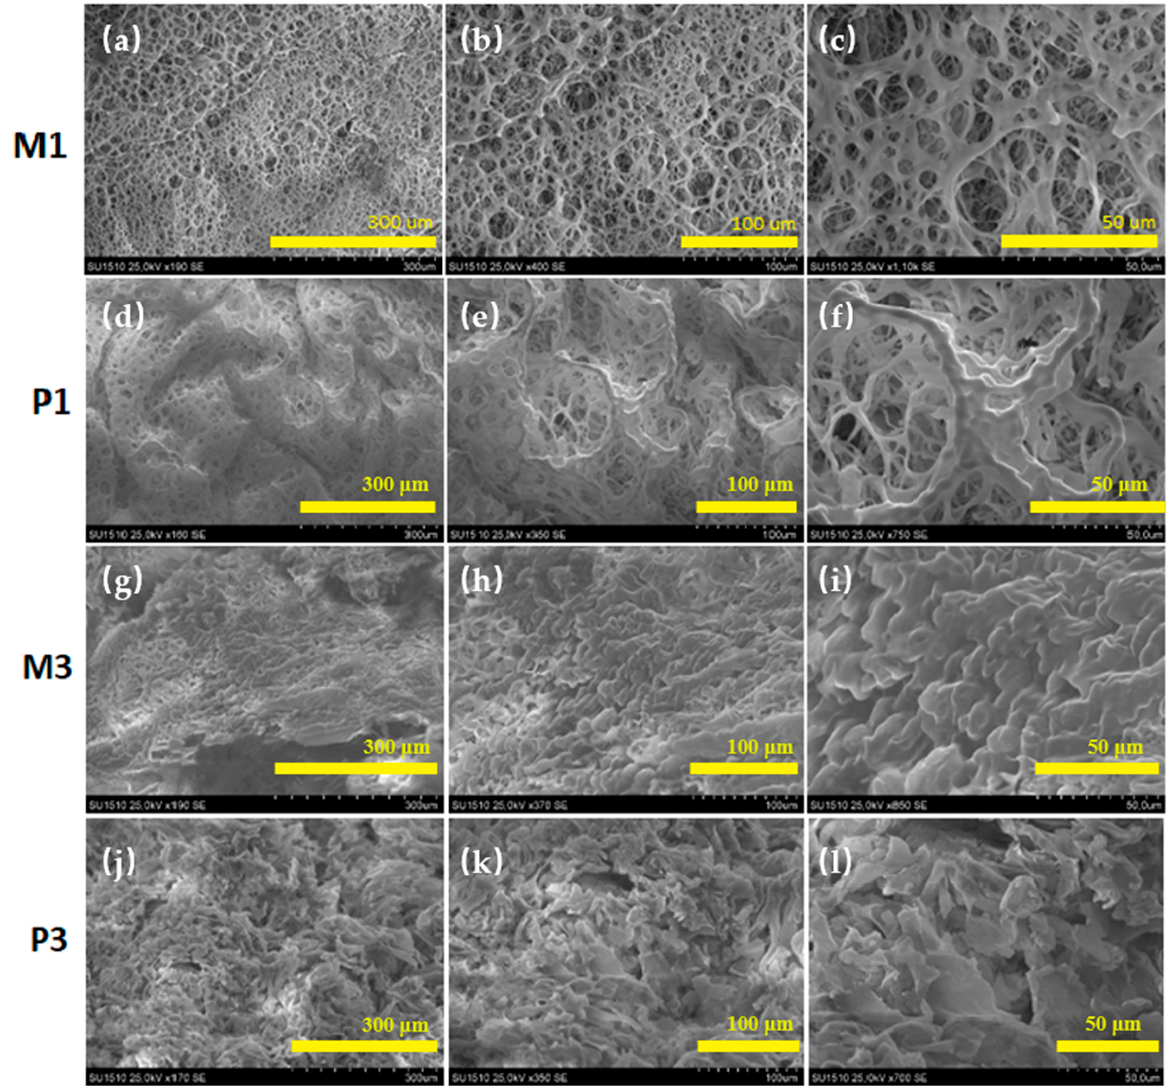
Figure 4. SEM images of freeze-dried CS-g-PNIPAAm/PVA 80/20 (M1, P1) and 75/25 (M3, P3). P1: (M3, P3). P1: CS-g-PNIPAAm/PVA 80/20 +PGT; M1: CS-g-PNIPAAm/PVA 80/20 ; P3: CS-g- CS-g-PNIPAAm/PVA 80/20 +PGT; M1: CS-g-PNIPAAm/PVA 80/20 ; P3: CS-g-PNIPAAm/PVA 75/25 PNIPAAm/PVA 75/25 +PGT; M3: CS-g-PNIPAAm/PVA 75/25 +PGT; M3: CS-g-PNIPAAm/PVA 75/25.